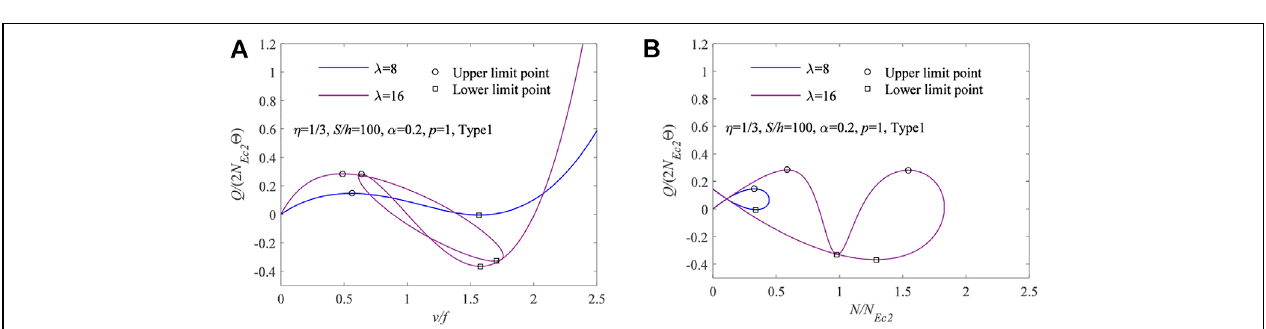
FIGURE 7 | Multiple limit point instability for pin-ended FGM arches using different equivalent slenderness: (A) v / f − Q /(2 N Ec 2 Θ ) curves. (B) N / N Ec 2 − Q /(2 N Ec 2 Θ ) curves.